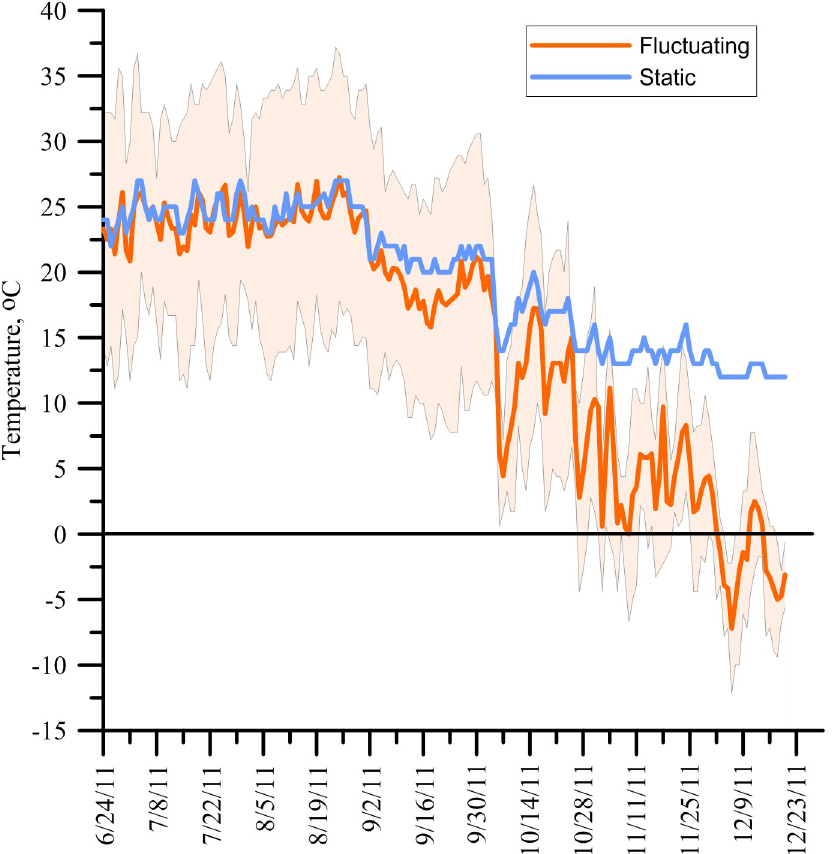
Fig 1. Experiment 1 air temperatures recorded from 24 June 2011 to 22 December 2011. The solid orange line indicates the average daily outdoor (fluctuating) temperatures with the borders of the shaded region indicates the maximum and minimum daily temperatures. The solid blue indicates the average daily indoor (static)